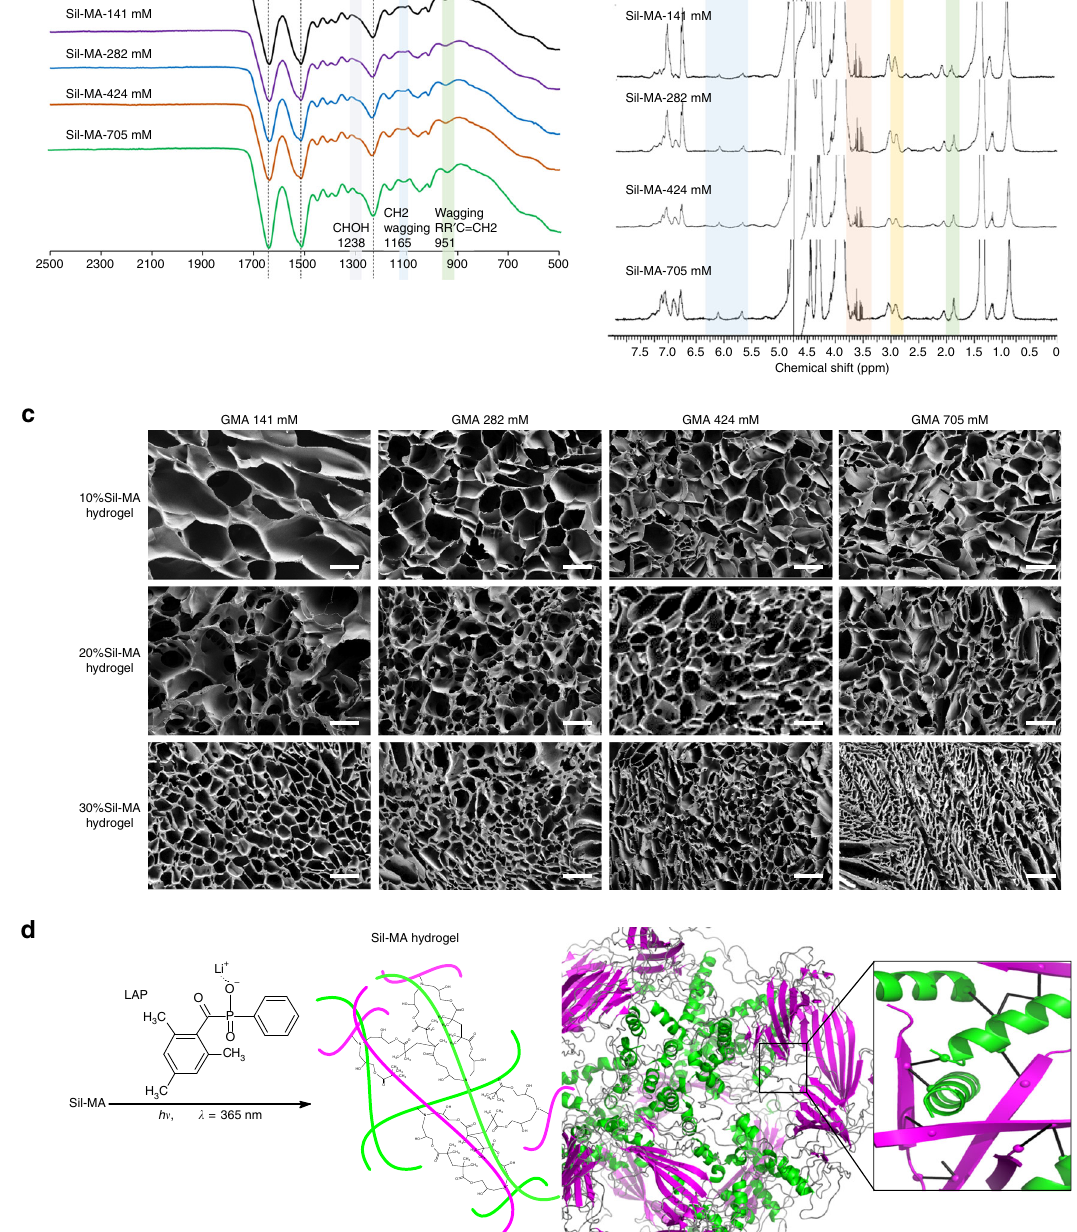
Fig. 2 Characterization of Sil-MA pre-hydrogel and Sil-MA hydrogel depending on methacrylation degrees. a FT-IR spectra and b 1 H-NMR spectra of unsubstituted SF and Sil-MA. In the FT-IR spectra, amide I (1639 cm − 1 ), amide II (1512 cm − 1 ), and amide III (1234 cm − 1 ) shown in β -sheet of SF and spectra related with GMA such as CHOH, RR ′ C = CH 2 were found. The modi fi cation of lysine residues in SF with the increase of GMA was con fi rmed by the gradual decrease in the lysine signal at δ = 2.9 ppm and the increase in the methacrylate vinyl group signal at δ = 6.2 – 6 and 5.8 – 5.6 ppm, and the methyl group signal at δ = 1.8 ppm. c FE-SEM images of Sil-MA hydrogels, presenting the effect of the degree of methacrylation and Sil-MA contents on the pore sizes of Sil-MA hydrogels. Scale bar represents 100 μ m. d Reaction process for the photopolymerization of Sil-MA in the presence of LAP photoinitiator and 3D structure of Sil-MA hydrogel formed via digital light process (DLP) printing. With the presence of photoinitiator, the vinyl double bonds on GMA could react with each other intra-chain or between chains. SF chains themselves could entangle each other during photopolymerization. Green and magenta colors indicate alpha helix and beta sheet motif in the secondary structure of SF,